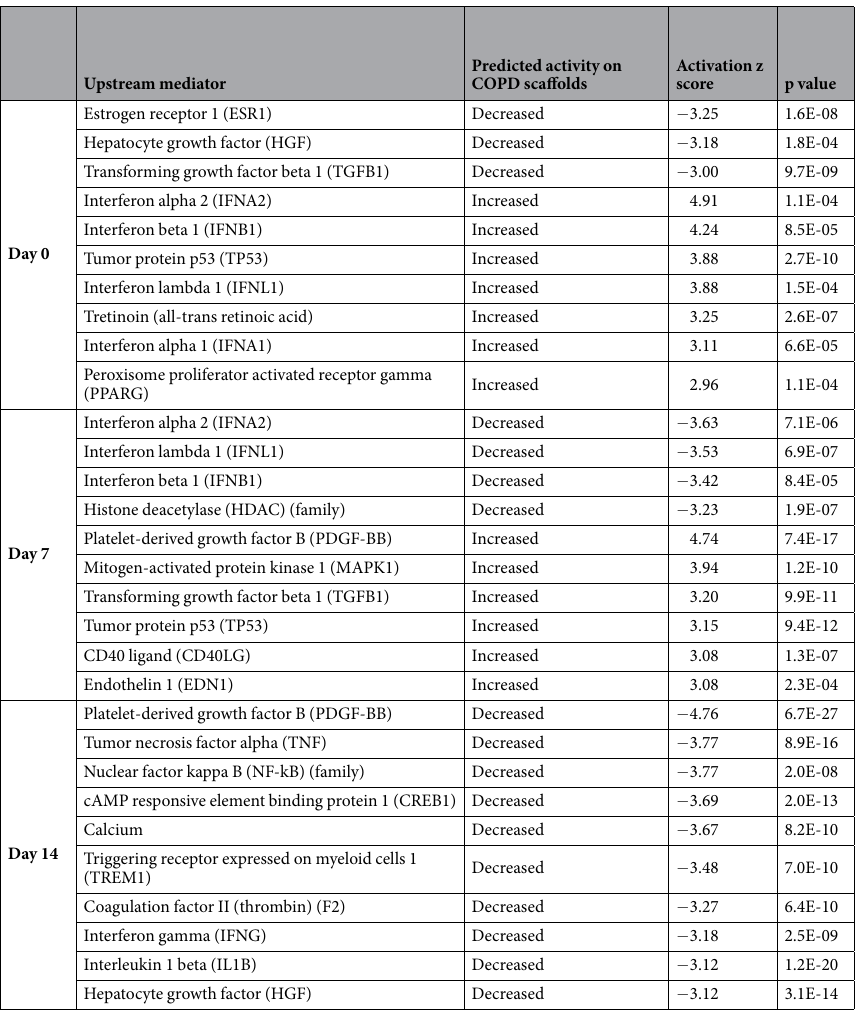
HES1 had a similar overall expression pattern in cells on COPD and normal scaffolds, but with temporal differ- ences, reaching their peak expression earlier on COPD scaffolds. The RNA-Seq data showed that mRNA expression aligned well with protein expression for the cellular mark- ers used for IHC (supplementary Fig. S5), although there were some significant differences in mRNA expression between COPD and normal samples. RNA-Seq data for selected genes were validated with real-time qRT-PCR and the results were consistent between the two methods (supplementary Fig. S6). Data for genes representing the matrisome 31 were extracted from the RNA-Seq data and 413 out of 1068 matrisome genes were expressed across all samples. 122 of these were differentially expressed in cells on COPD compared to normal scaffolds on day 0. However, on day 7 and 14 that number had decreased to 27 and 22, respectively, and on day 21–35 no more than one gene was differentially expressed at each time point. This demonstrates a converging expression pattern also for genes encoding ECM proteins (supplementary Fig. S7A,B).